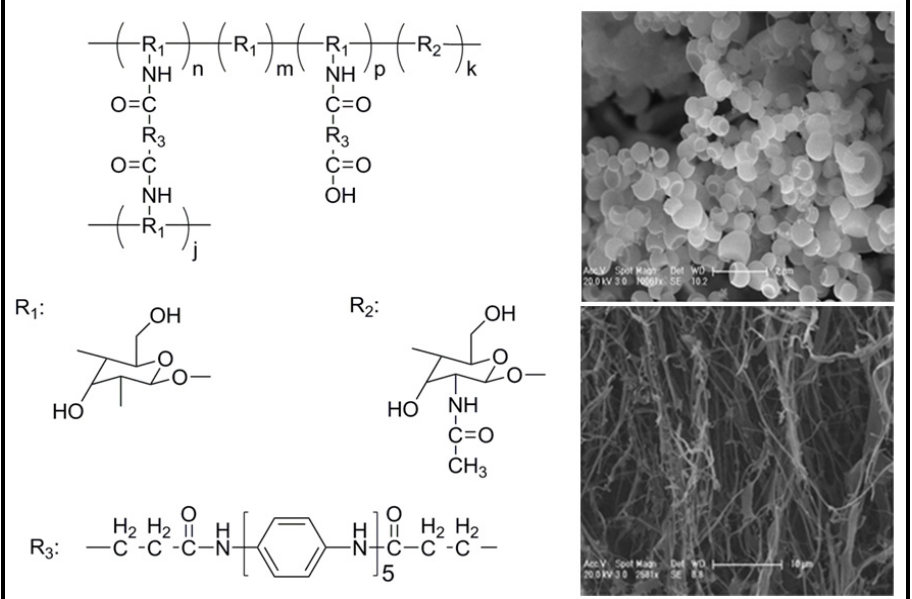
Figure 14. Chemical structure of aniline pentamer cross-linking chitosan (AP- cs -CS) ( left ) and scanning micrographs ( right ) showing nanomicelles of AP- cs -CS and the typical morphology of CS. Reprinted with permission from [49]. Copyright 2008 American Chemical